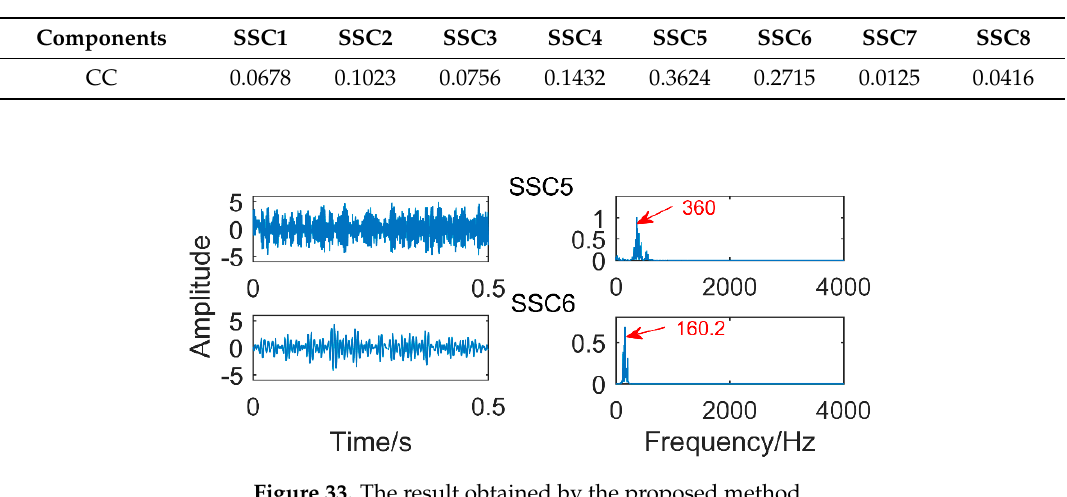
Figure 32. Results obtained by MEDA for processing the signal.